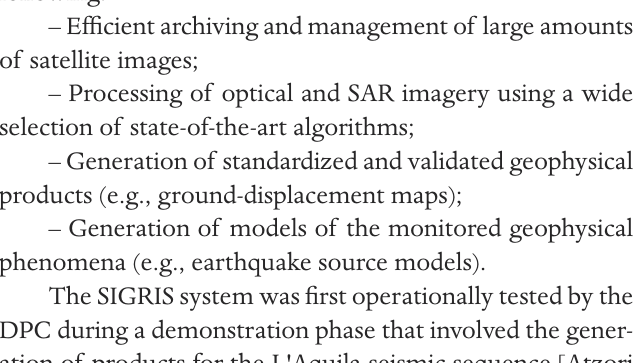
Figure 1. The area of the 2012 seismic sequence. Stars, largest events of the sequence, numbered in order of occurrence; 1, May 20, 2012, M 4, May 29, 2012, M 5.8 event; small dots, selection of smaller aftershocks. The outline boxes (dotted for the ascending orbit, continuous for the de- L scending orbit) show the strip-map COSMO-SkyMed scenes used to cover the epicentral